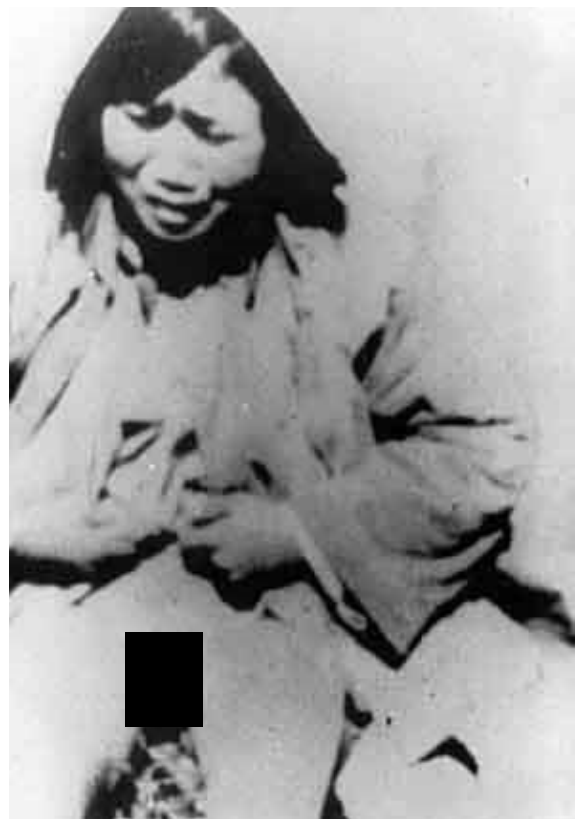
Figure 15. The humiliation of sexually ravaged women. Source: Nanjing Massacre Memorial